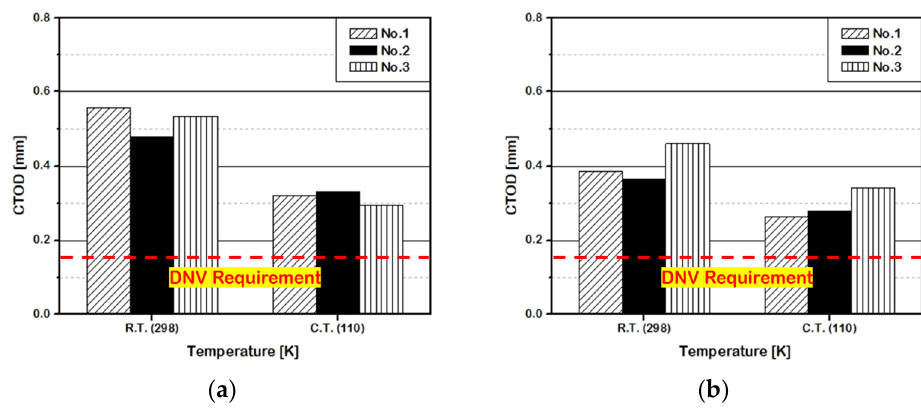
Figure 10. CTOD test results of weld metals: ( a ) high Mn; ( b ) 9% Ni.